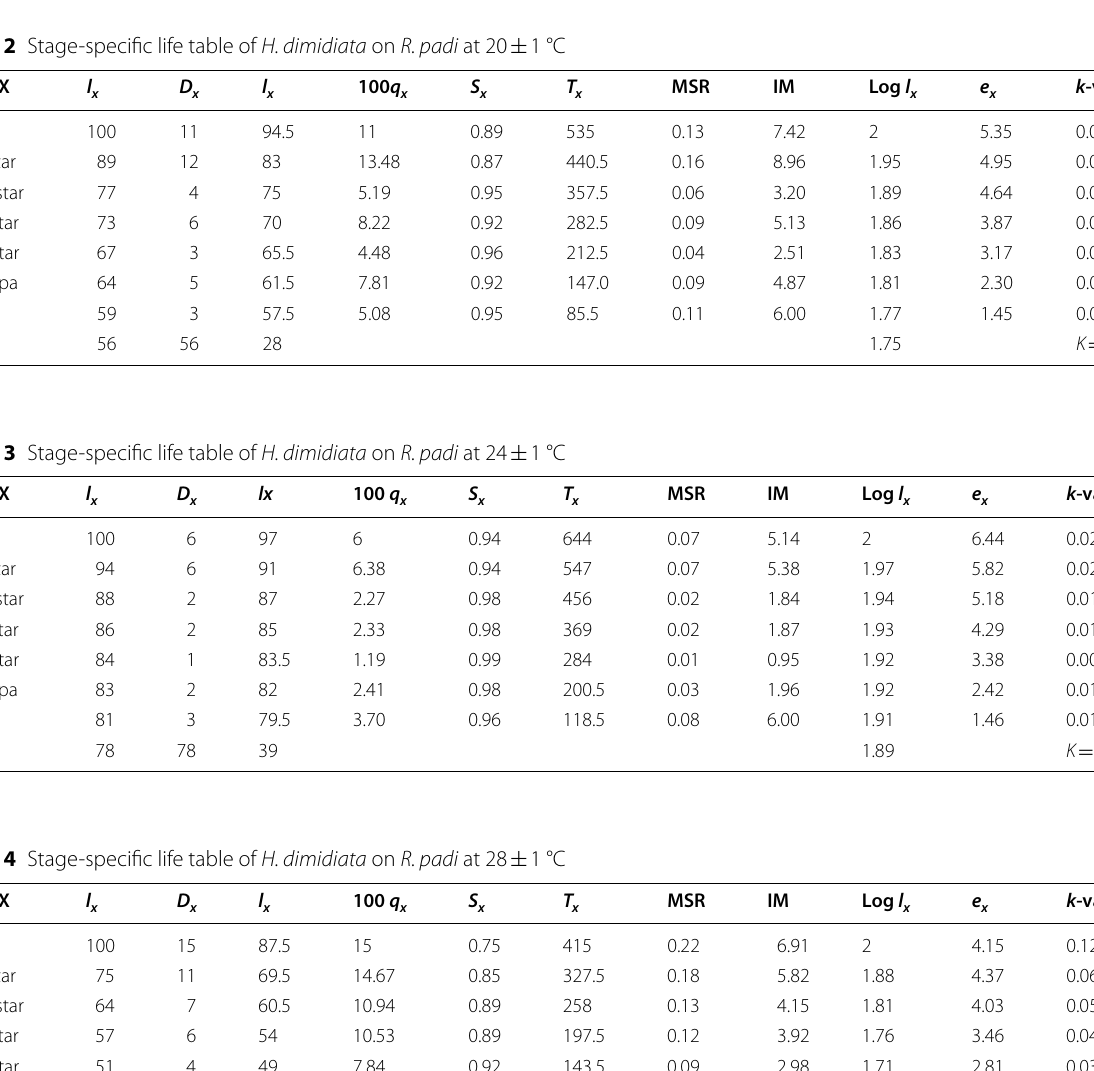
Table 2 Stage-specific life table of H. dimidiata on R. padi at 20 Stage X